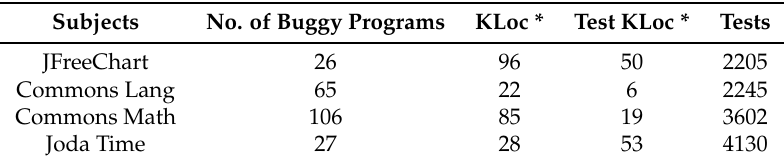
Table 1. Defects4j benchmark for experiments